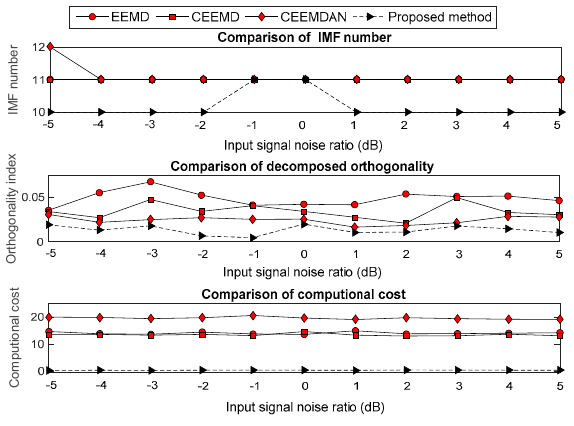
Figure 7. Comparison of the decomposition effect for the ‘blocks’ signal.